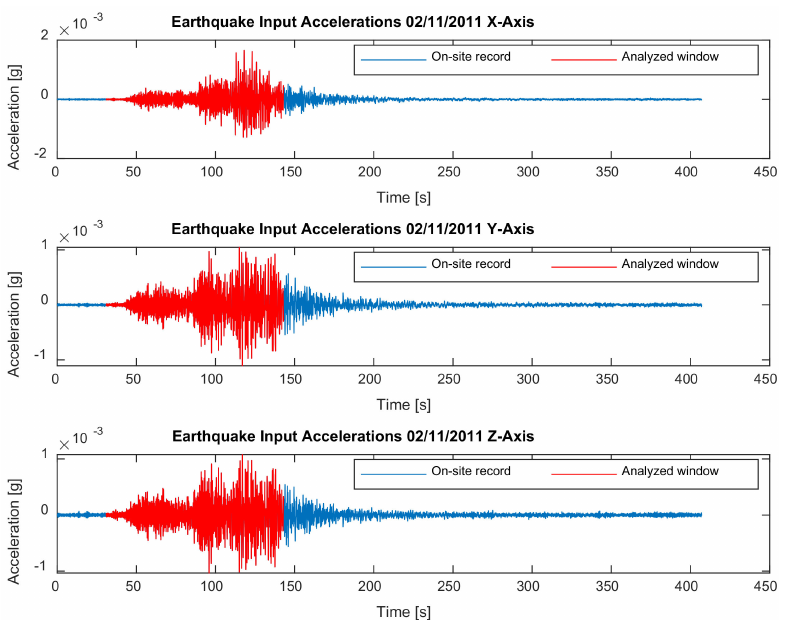
Figure 5. On-site seismic recording at the foundation of the building and time